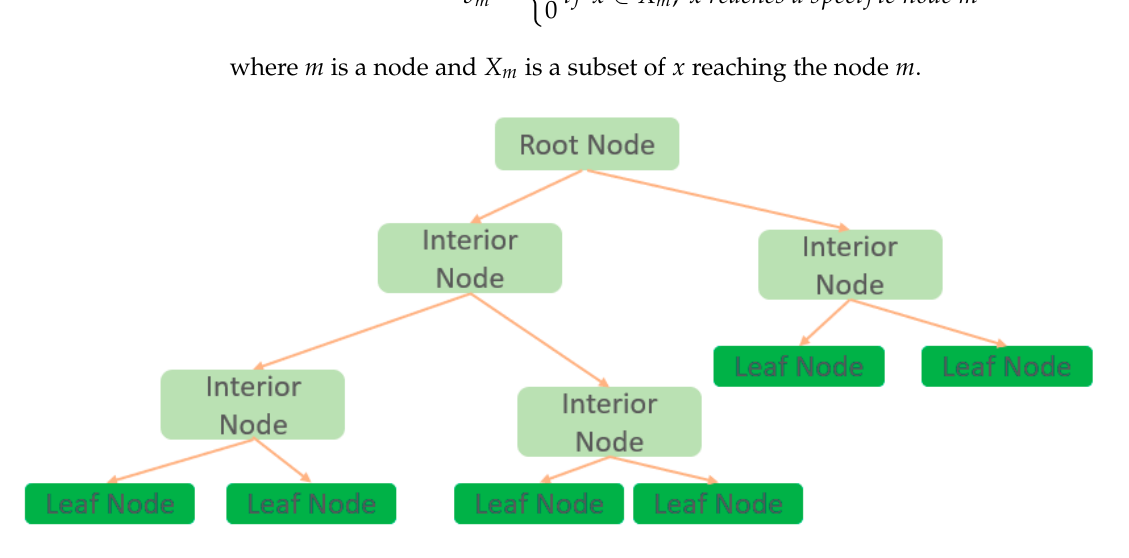
Figure 3. Decision tree model.